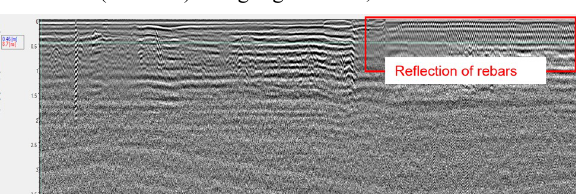
Figure 9. Concrete slab and rebar mesh affecting data quality and interpretation in Marina